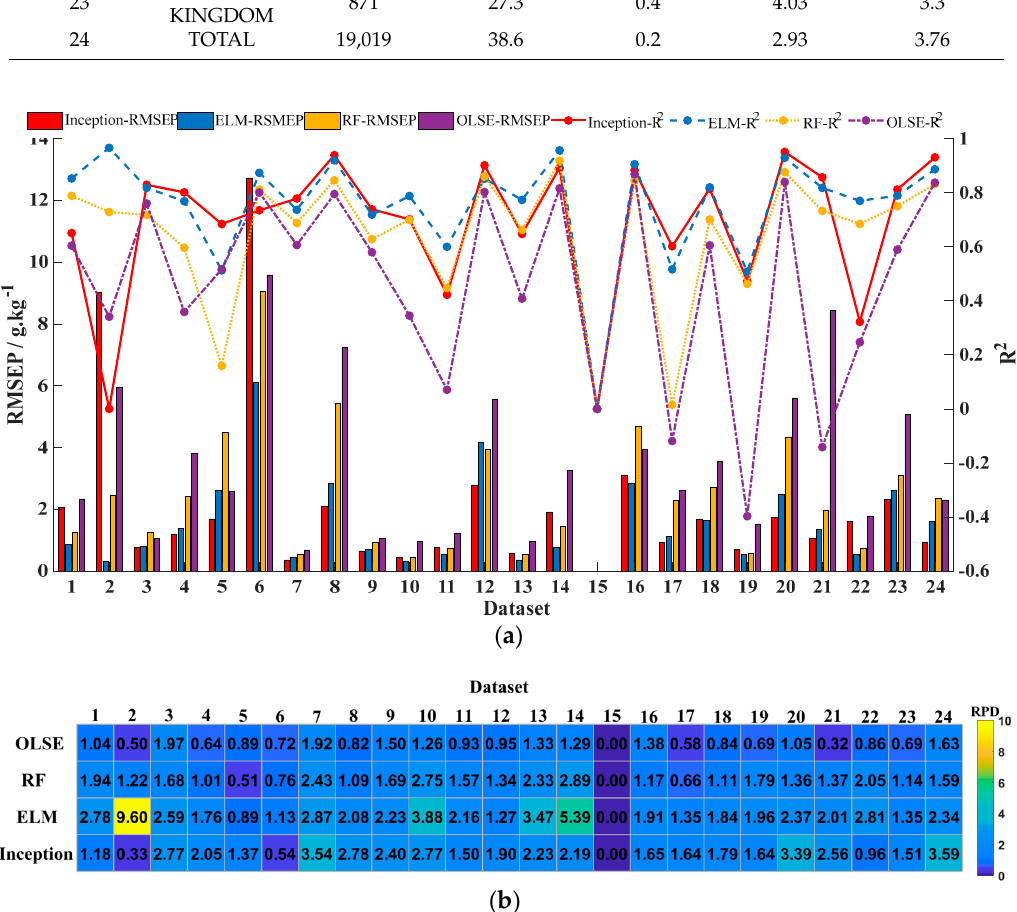
Figure 8. Effects of different predicted models with different datasets from different countries. ( a ) Figure 8. E ff ects of di ff erent predicted models with di ff erent datasets from di ff erent countries. Accuracy of different predicted models. ( b ) Credibility of different predicted models. ( a ) Accuracy of di ff erent predicted models. ( b ) Credibility of di ff erent predicted